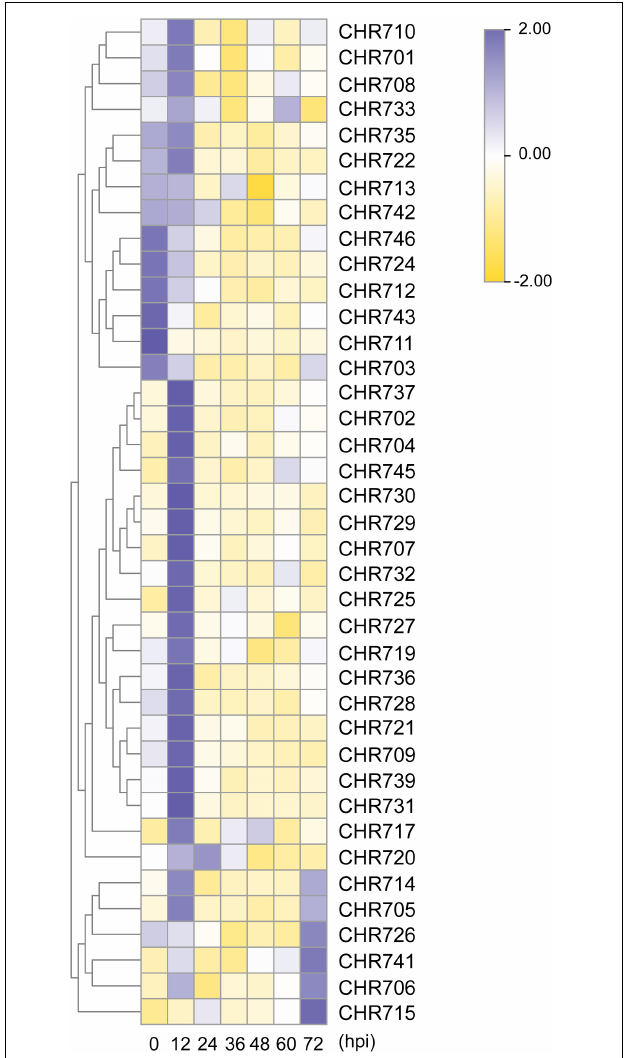
FIGURE 6 | The relative expression level of Snf2 genes under M. oryzae stress. The expression analysis of Snf2 genes under the infection causal agent of rice blast. Heat map representing the temporal expression patterns was constructed by the heatmap packages in R. The data was normalized using OsUBQ5 as the internal reference gene. hpi, hours